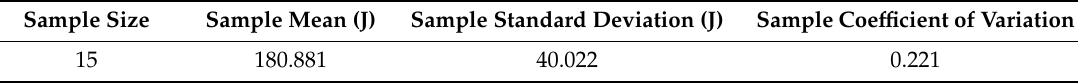
Table 3. Sample statistical data of transferred energy measured by the absorbing cup device.